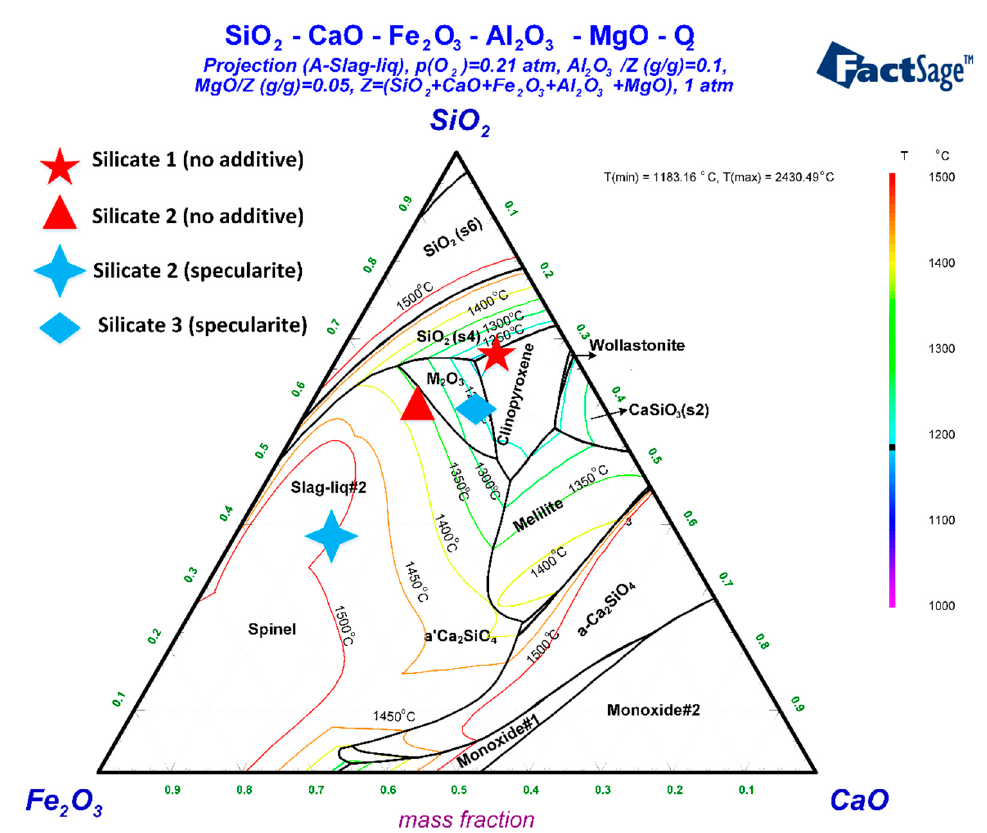
Figure 10. Phase diagram of SiO 2 -CaO-Fe 2 O 3 -10wt%Al 2 O 3 -5wt%MgO-O 2 (P (O2) = 0.21) calculated by FactSage 8.0 (marked Figure 10. phase diagram of SiO 2 -CaO-Fe 2 O 3 -10wt%Al 2 O 3 -5 wt %MgO-O 2 (P (O2) = 0.21) calculated by locations according to Table FactSage 8.0 (marked locations according to Table 5).